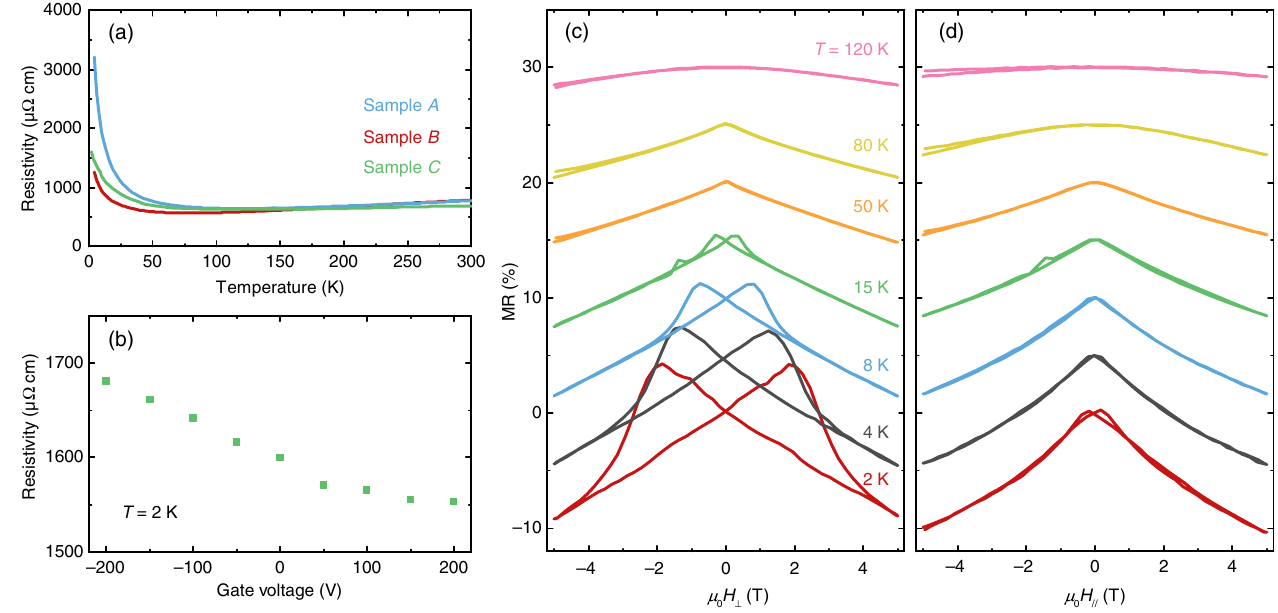
FIG. 11. Resistivity and magnetotransport of sample C . (a) Comparison of the temperature dependence of the resistivity between samples A , B , and C . (b) Electrostatic field-effect-dependent resistivity of sample C using a back gate. (c) Out-of-plane magnetoresistance. The MR curves are offset to avoid overlap. (d) In-plane